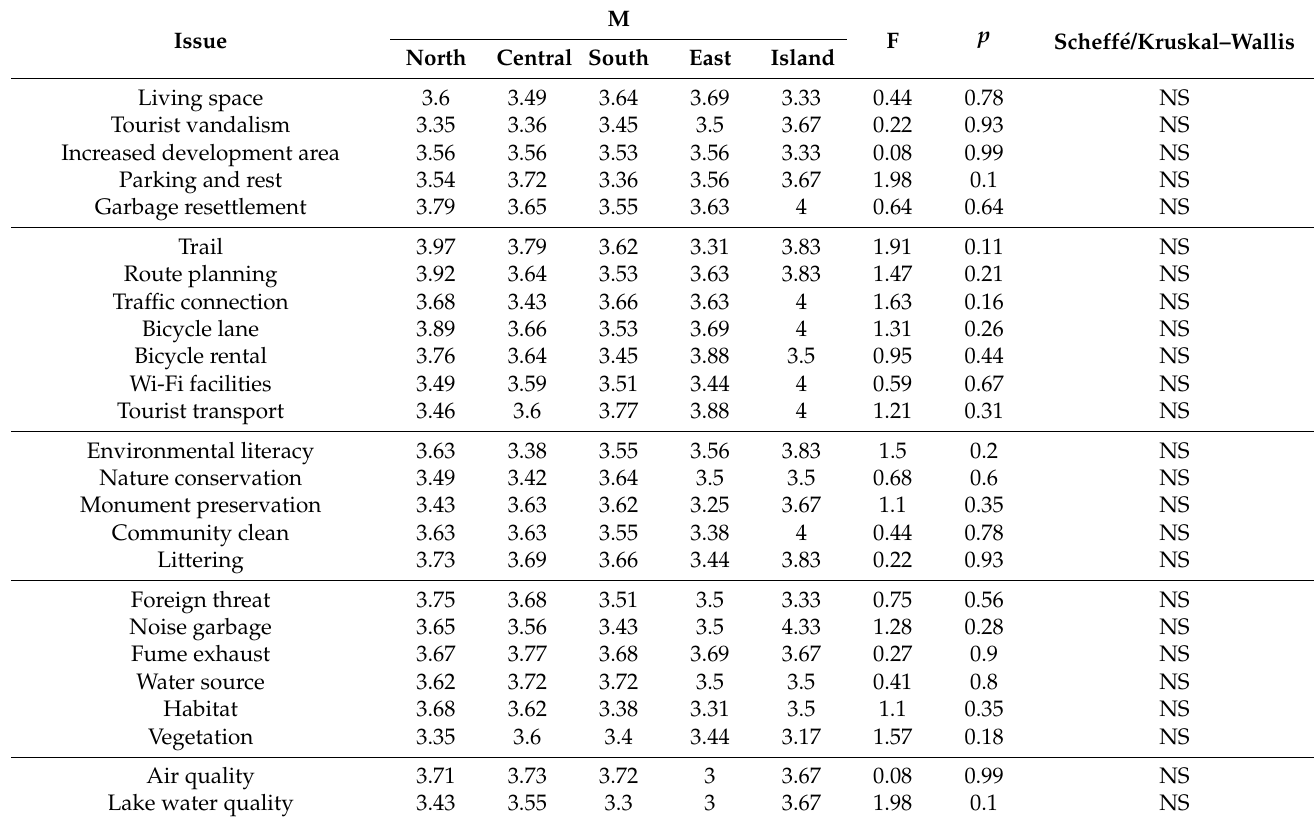
Table 6. Analysis of cognition of tourists from different regions about the current status of environmental development. M Issue F p Scheff é /Kruskal–Wallis North Central South East